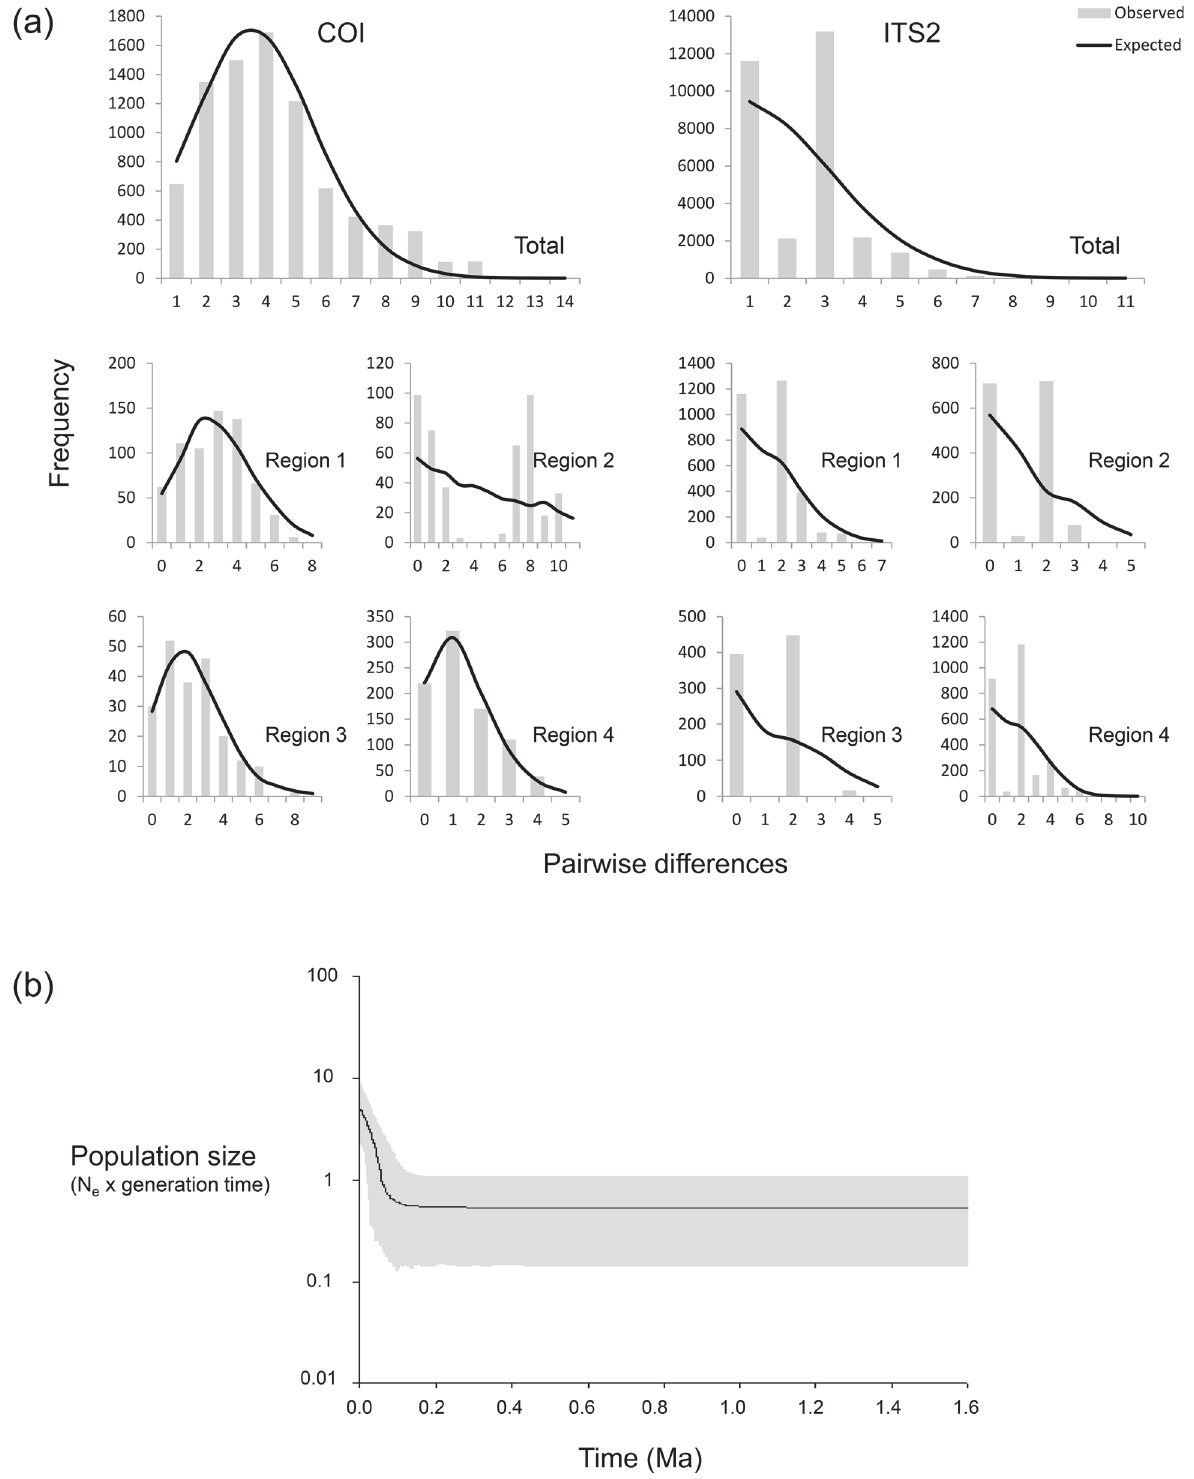
Fig 4. Results of demographic analyses. (a) Results of mismatch distribution analyses for COI (left) and ITS2 (right) total datasets and for each geographical region separately. (b) Demographic expansion detected by multilocus EBSP, with the 95% HPD interval shown in gray.